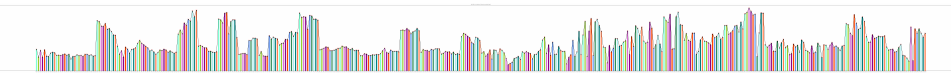
Figure 15. The in-air signature nine-dimensional concatenated length of a